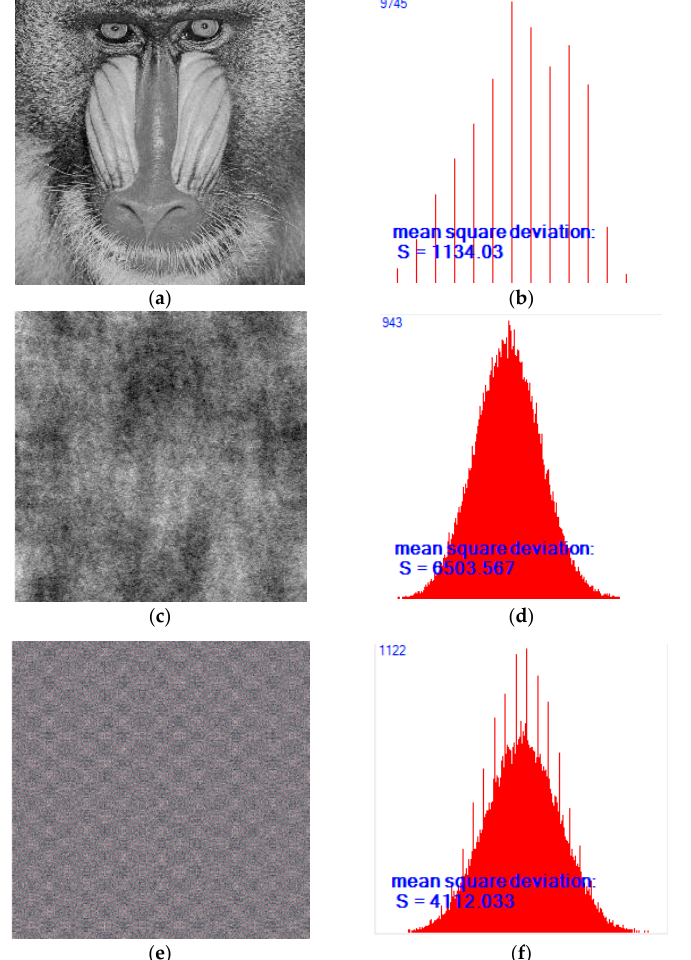
Figure 3. ( a ) Original image; ( b ) Histogram of original image; ( c ) Original image scrambling encryption image; ( d ) Histogram of image scrambling encryption image; ( e ) Improved image scrambling encryption image; ( f ) Histogram of improved image scrambling encryption image.